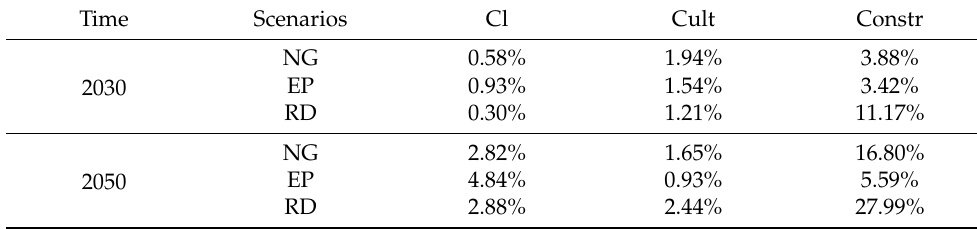
Table 8. Change in area increase of major land types compared to